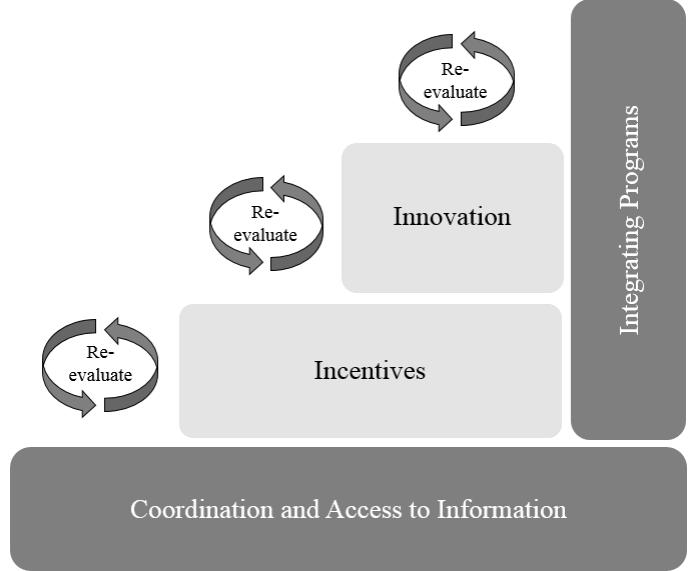
Figure 3. Related nature of the opportunities for innovation and the built-in process for flexibility and adaptability over time.